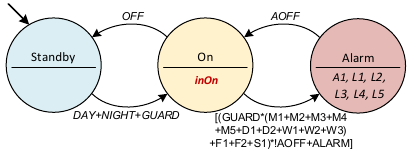
Figure 12. SHS—a UML state machine diagram on the lowest hierarchy level.